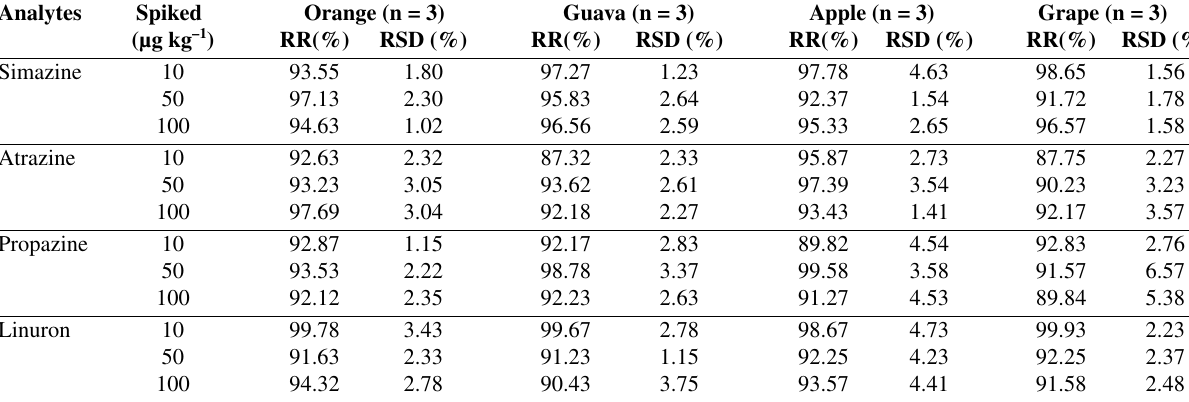
Table 5. Recovery obtained from the determination of target herbicides in fruit juice samples (n = 3)